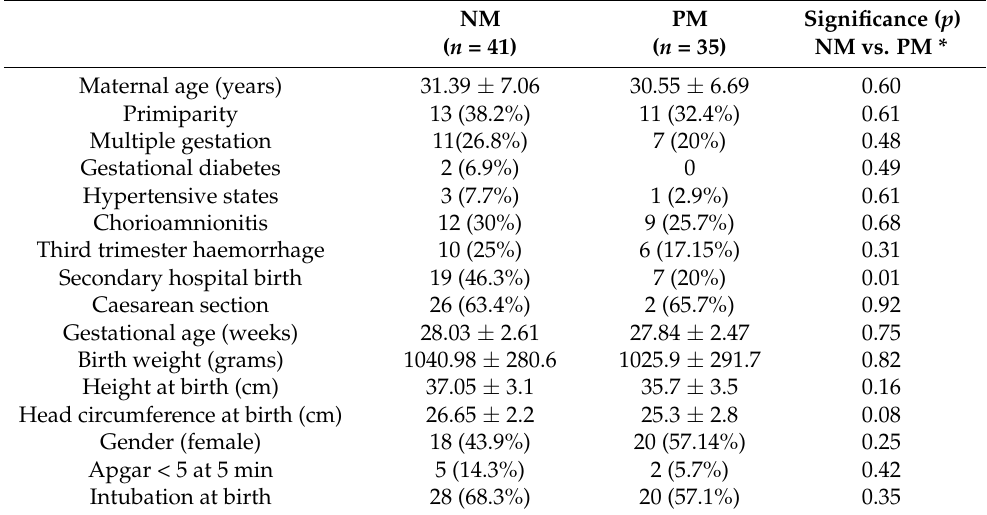
Table 1. Characteristics of the cohorts included in the study according to the maturation pattern.